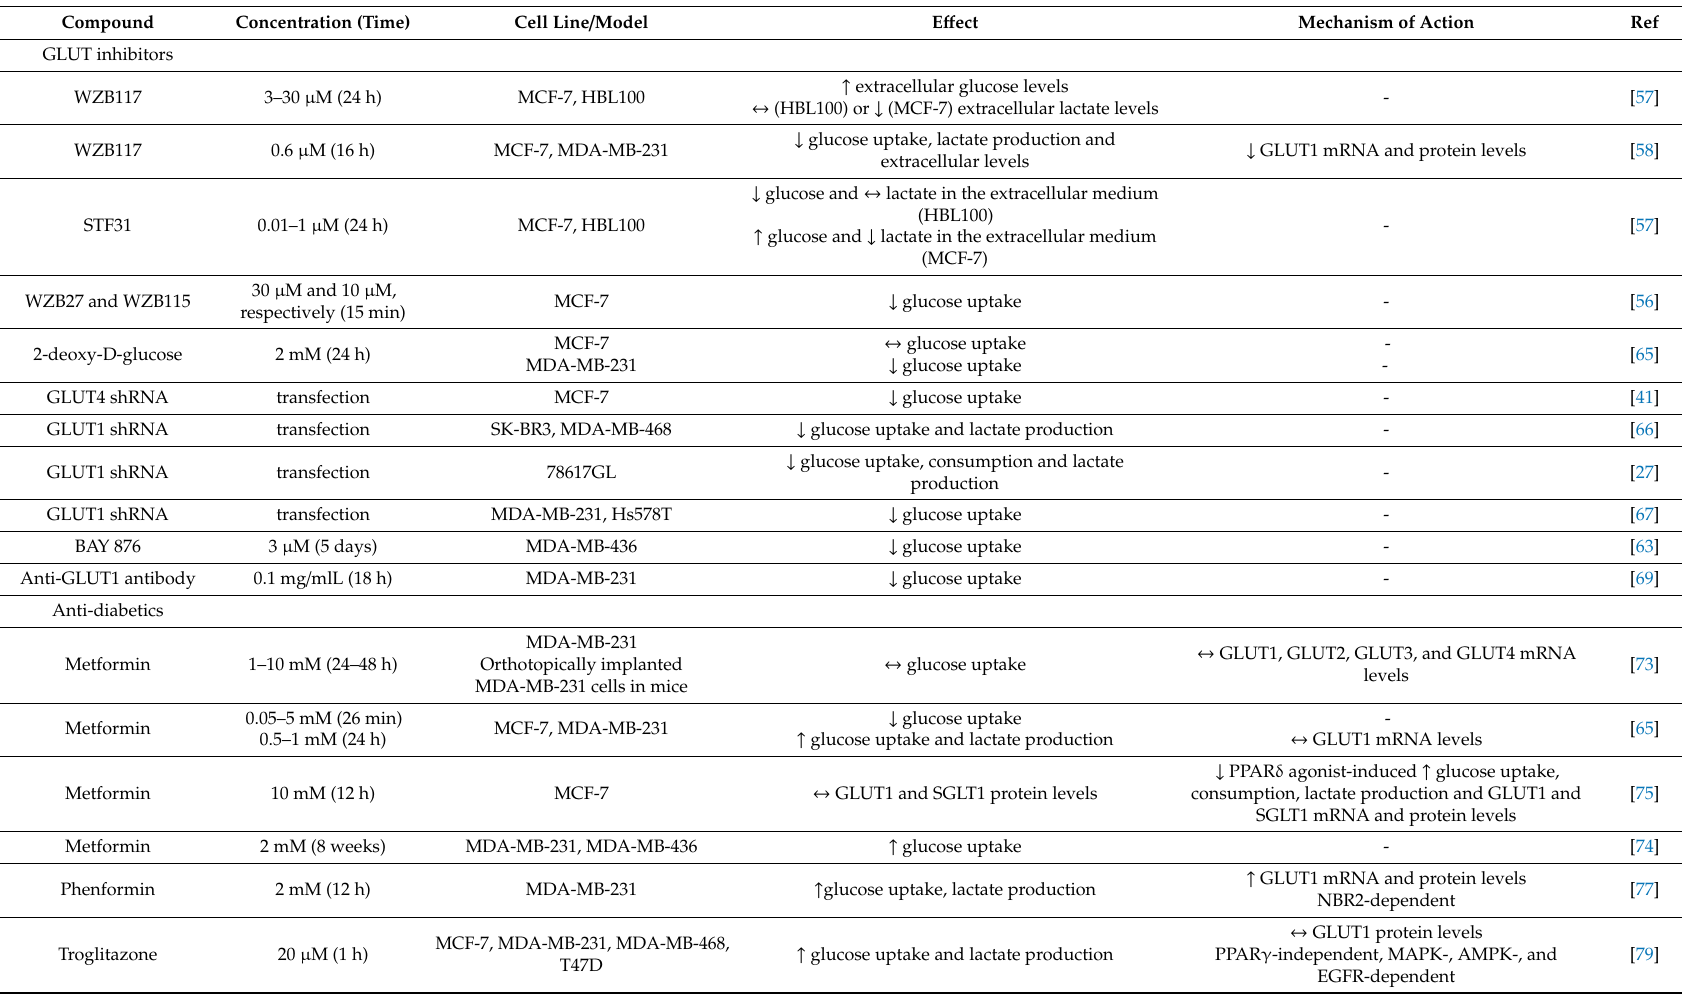
Table 1. E ff ect of synthetic compounds on glucose uptake by breast cancer